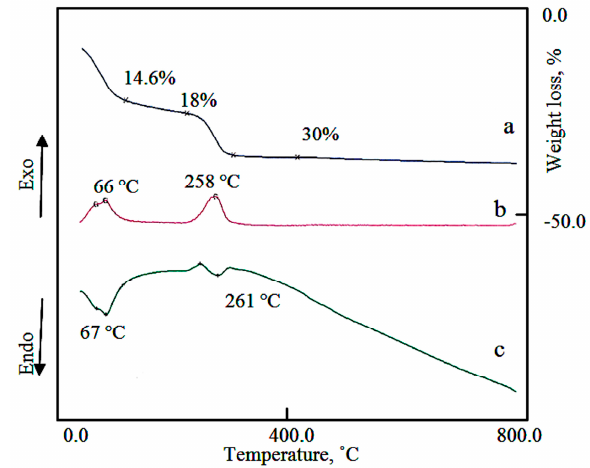
Figure 7. Thermal analyses of Co–Si LDHs after zirconium and titanium inclusion: ( a ) TG, ( b ) DTG, and ( c ) DTA.